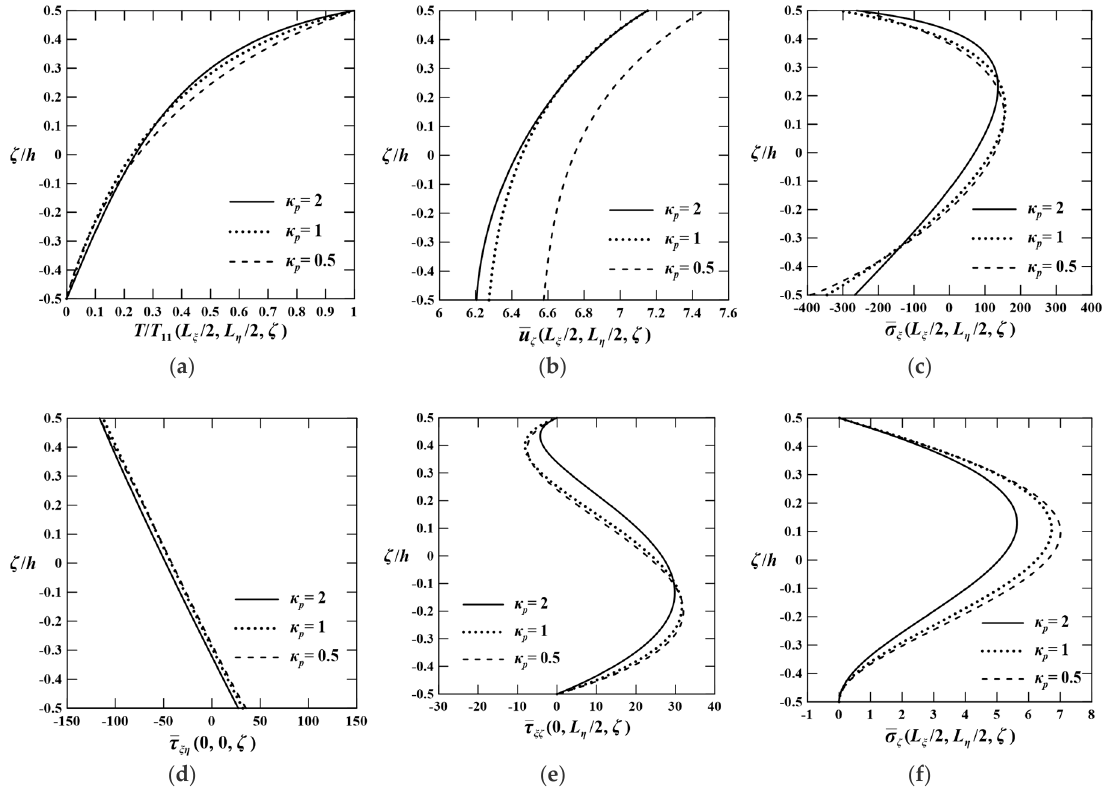
Figure 4. Through-thickness distributions of thermal and elastic field variables induced in an FG cylindrical shell with di ff erent values of κ p . ( a ) Temperature; ( b ) Out-of-surface displacement; ( c ) In-surface normal stress; ( d ) In-surface shear stress; ( e ) Transverse shear stress; ( f ) Transverse normal stress.